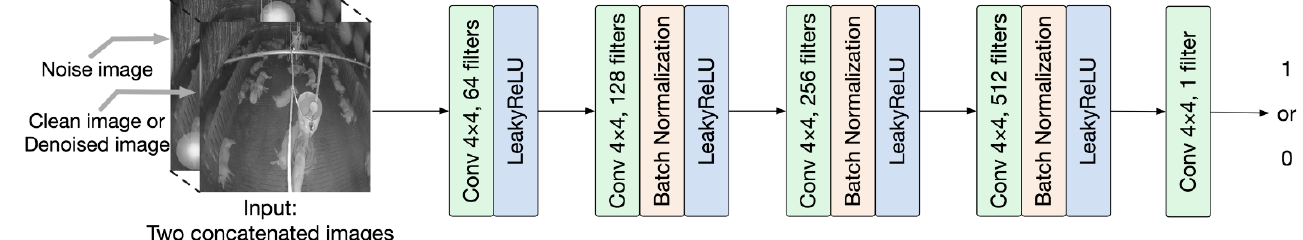
Figure 6. The structure of discriminator.